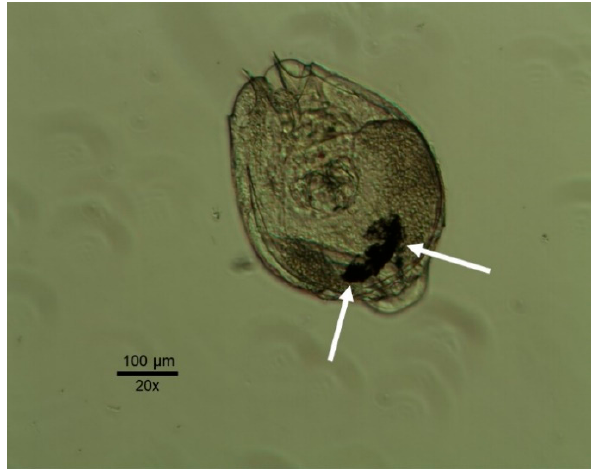
Figure 3. Photograph of dead Lecane quadridentata . Digestive tract filled with BC particles as indicated by the arrows. Table 7. Acute toxicity values of Lecane quadridentata to BCs 4 .